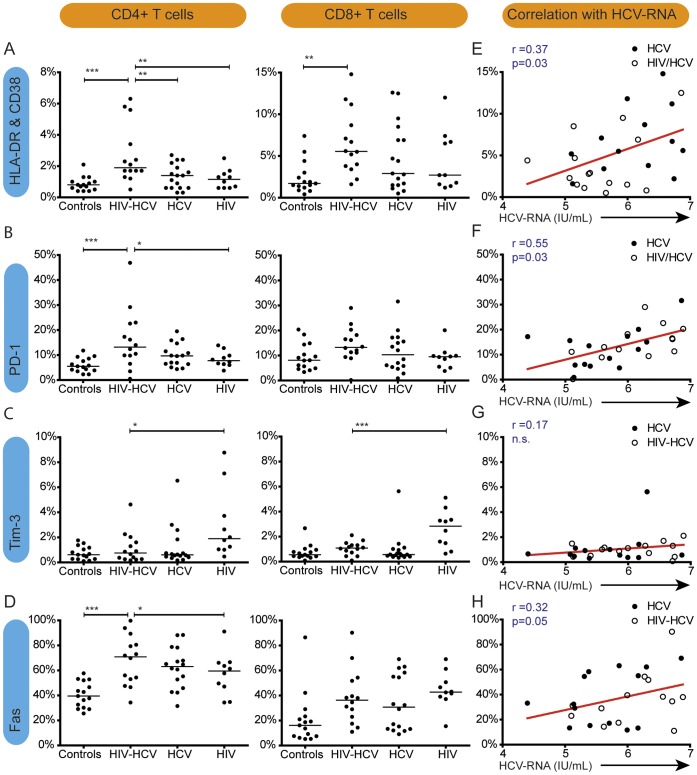
T-cell activation and exhaustion and its correlations with HCV-RNA in HIV/HCV-coinfection and control groups.A: percentages of HLA-DR+CD38+ activated CD4+ (left) and CD8+ T-cells (right). B: percentages of PD-1 positive CD4+ and CD8+ T-cells. C: percentages of Tim3-positive CD4+ and CD8+ T-cells. D: percentage of death receptor Fas positive CD4+ and CD8+ T cells. E-H: correlations of HCV viral load within HIV-HCV coinfected (open dots) and HCV monoinfected patients (closed dots) with percentages of HLA-DR and CD38 positive CD8 T cells (E); PD-1 positive CD8 T cells (F); Tim-3 positive CD8 T cells (G) and Fas positive CD8 T cells (H). HCV viral loads are depicted in IU/mL. P-values are indicated with * (p<0.05), ** (p<0.01) or *** (p<0.0001). Spearman r and p-value of correlations are depicted in the upper left corner of each graph; red lines represent semilog fit lines.